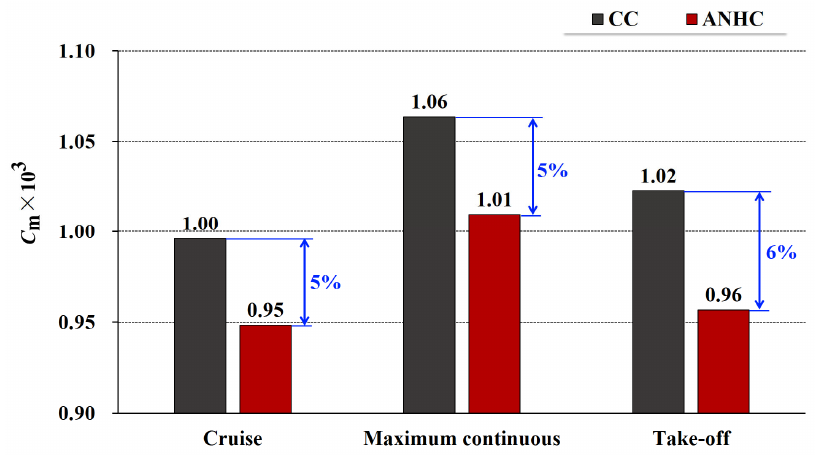
Figure 18. Moment coefficient of rotating disk surface under CC and ANHC.